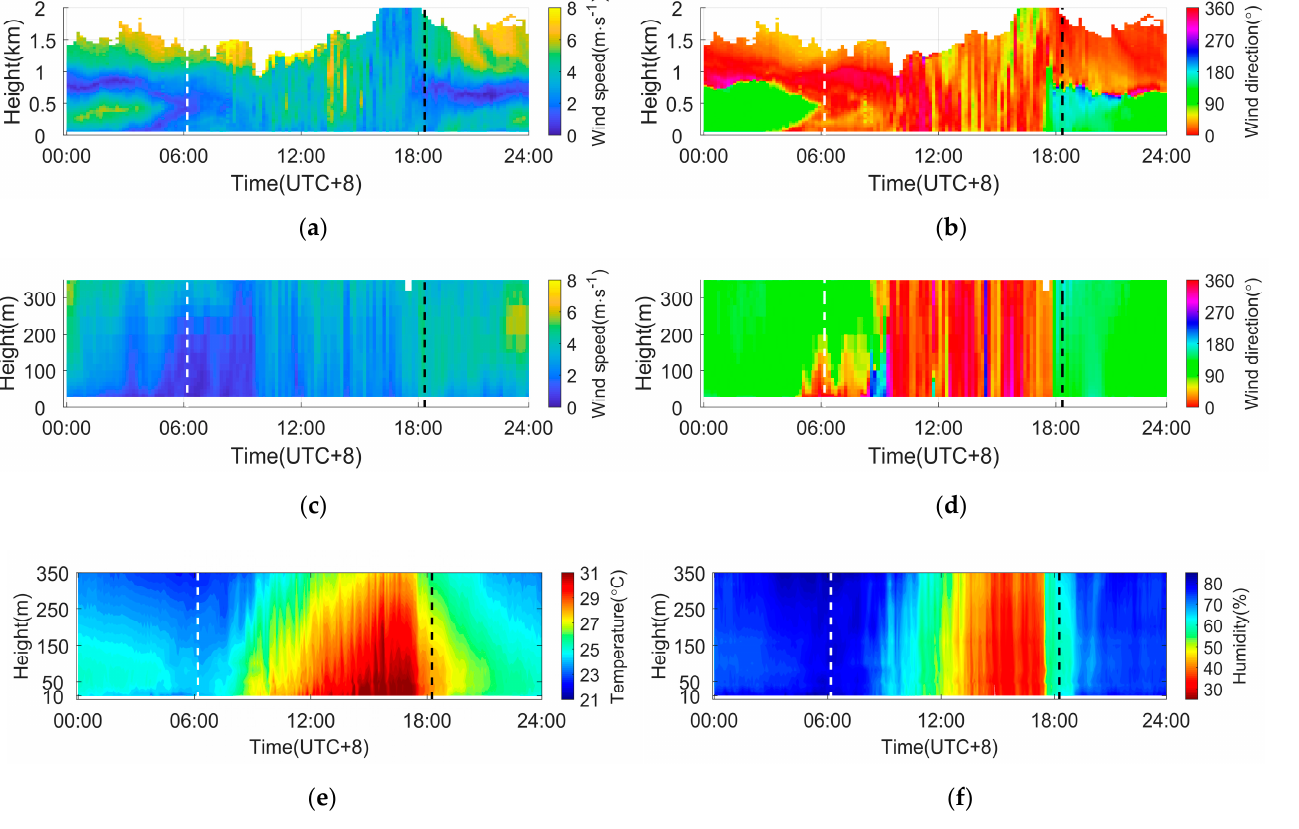
Figure 4. The observation results of conventional meteorological data on 25 September 2019. ( a ) wind speed by Wind3D 6000; ( b ) wind direction by Wind3D 6000; ( c ) wind speed by WindMast WP350; ( d ) wind direction by WindMast WP350; ( e ) temperature and ( f ) humidity by sensors on the tower. The white dotted line represents the sunrise time and the black one represents the sunset time.